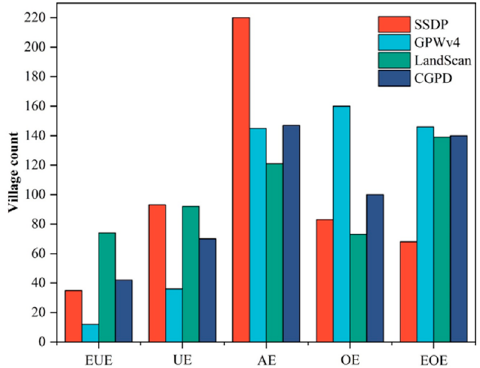
Figure 7. Village count with different error ranges in samples.